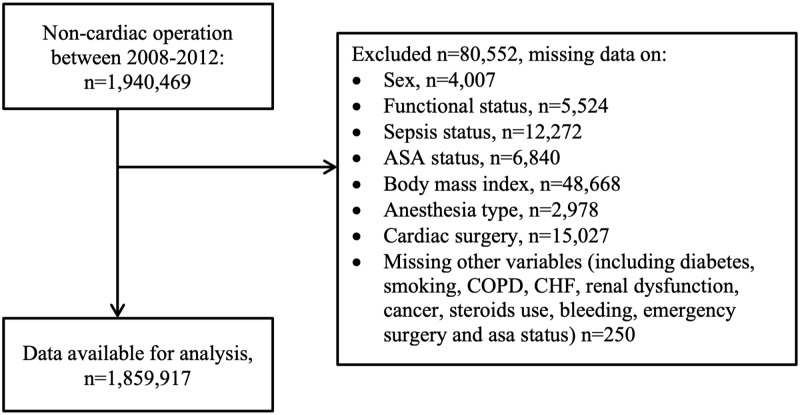
Flow diagram of patient selection.COPD: Chronic Obstructive Pulmonary Disease, CHF: Congestive Heart Failure, ASA: American Society of Anesthesiologists.